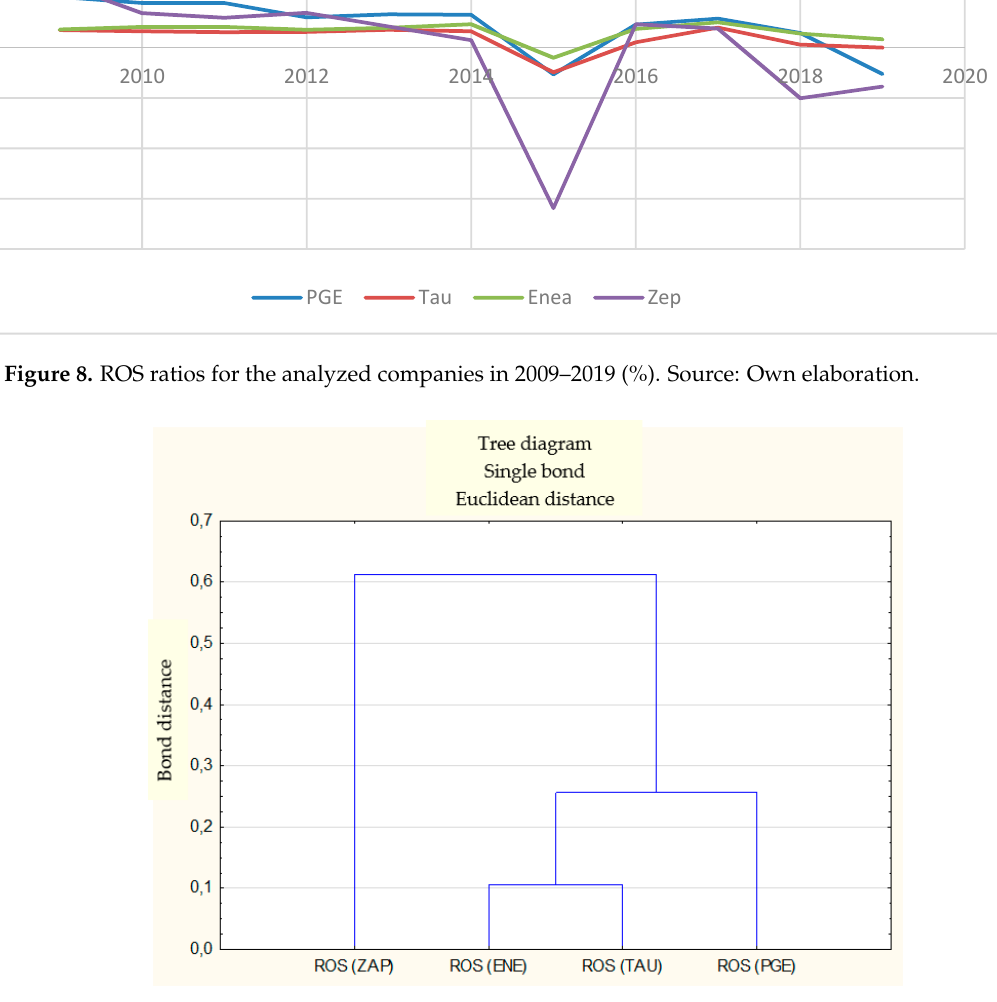
Figure 9. Dendrogram grouping the surveyed companies in terms of ROS. Source: Own elaboration. Table 4 and Figure 10 contain the coefficients of variation and standard deviations for the ROS ratio. Table 4. Coefficients of variation and standard deviations for ROS of the surveyed